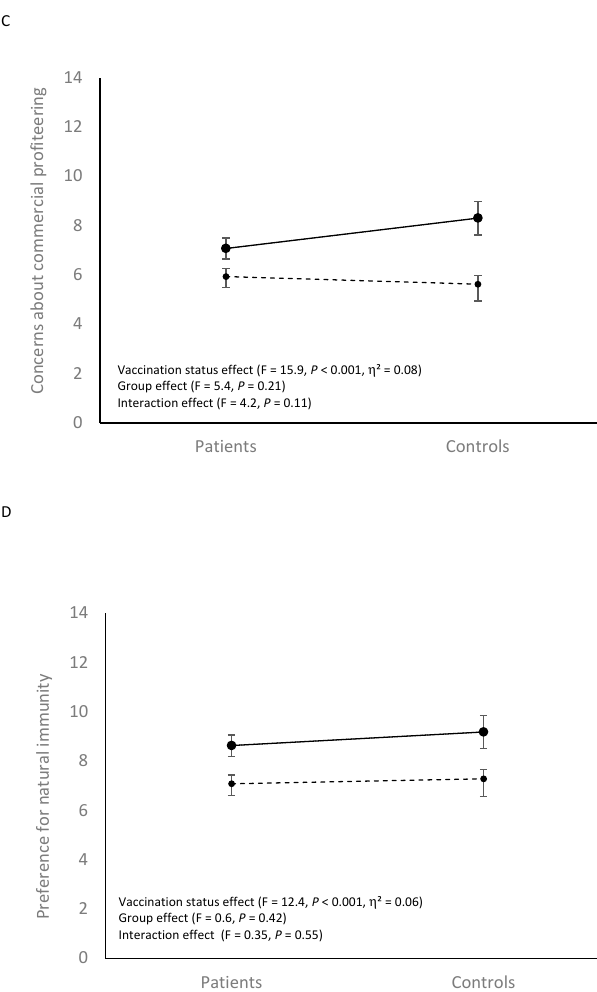
Figure 1. Vaccination Attitudes Examination Scale dimensions for patients and controls according to vaccinal status. Means ( ± standard error of the mean) are given. ( A – D ) correspond to the 4 dimensions of the Vaccination Attitudes Examination